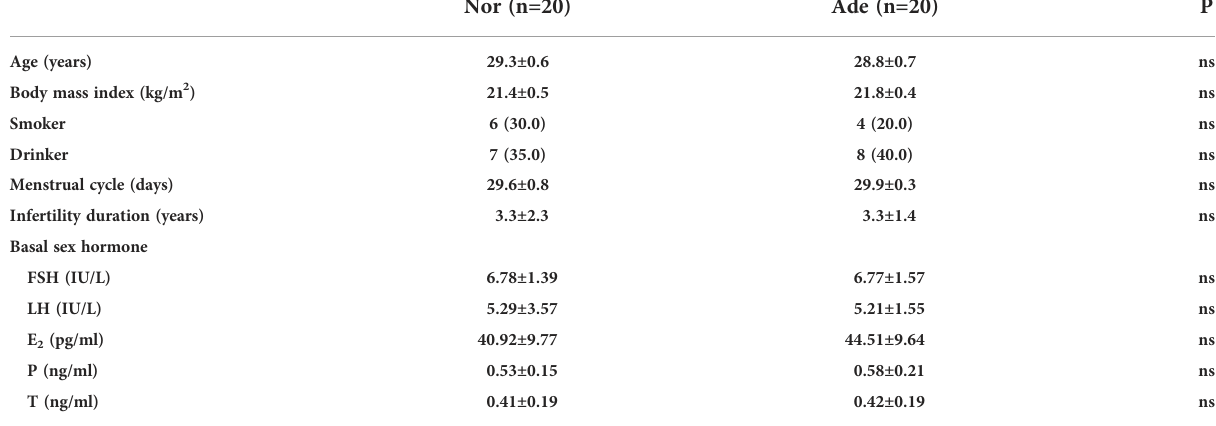
TABLE 1 Patients